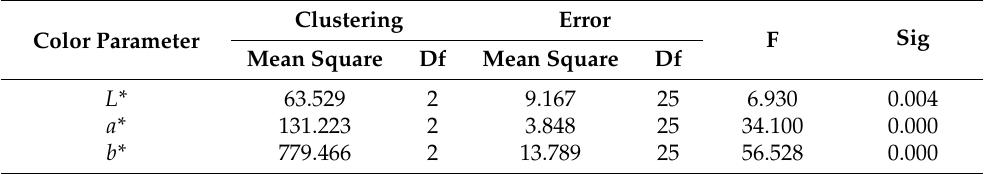
Figure 7. Color grading of yellow-green opal under D65 light source and N9.5 background. ( a ) Three groups of yellow-green opals in three-dimensional projection: Fancy Intense, Fancy Deep, and Fancy; ( b ) Color distribution of three groups of yellow-green opal samples. Table 3. Cluster analysis results of yellow-green opal color.